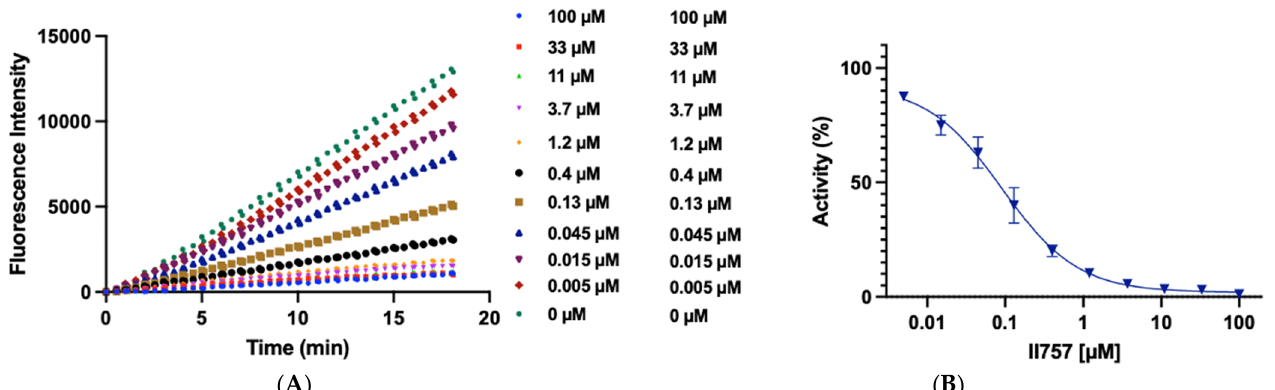
Figure 3. Biochemical characterization of compound II757 ( 6l ). ( A ) SAHH-coupled fluorescence assay of compound II757 at 4 K m substrate concentration ranging in concentrations from 0 to 100 µM and ( B ) concentration–response plot for compound II757 . All experiments were performed in duplicates (n = 2).